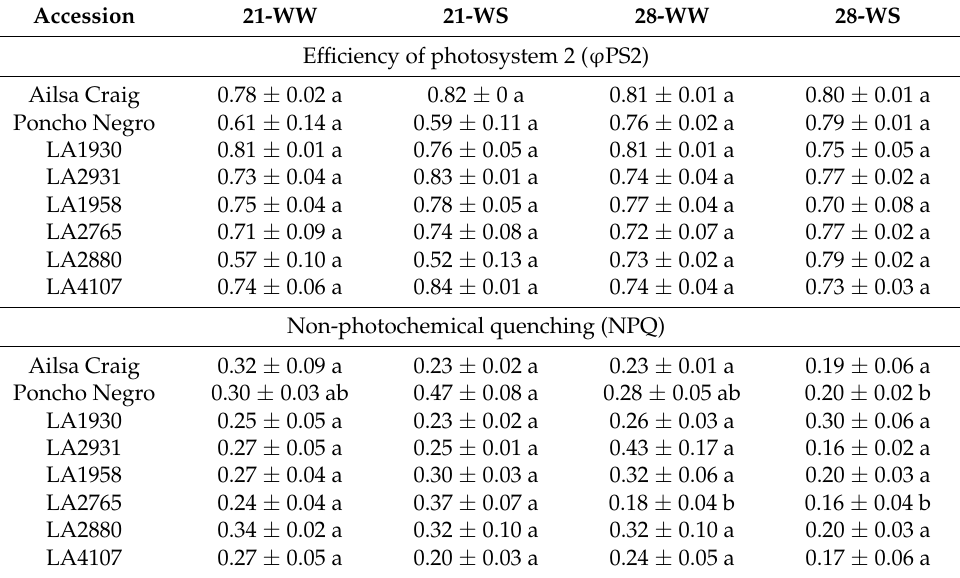
Table 2. Effect of temperature and water stress on chlorophyll fluorescence parameters of S. lycoper- sicum cultivars and S. chilense populations. For a given accession, treatments followed by different letters are significantly different at p < 0.05. Data ± SE.